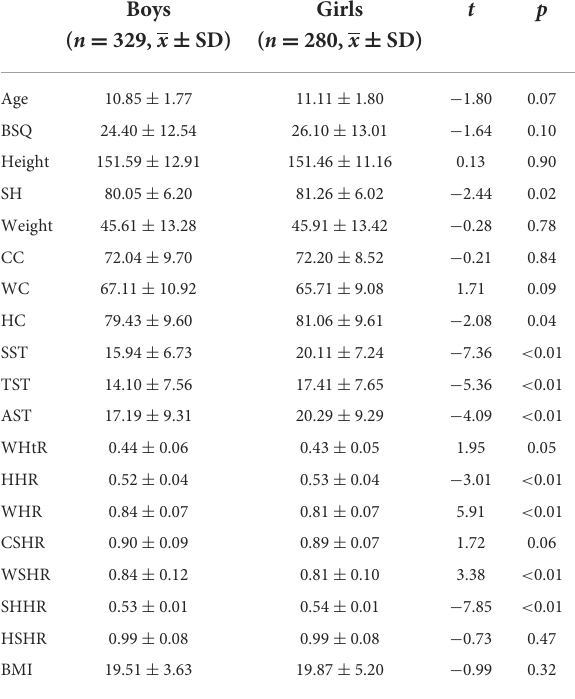
TABLE 1 The comparisons of BSQ score, anthropometric indices between boys and girls ( x ±